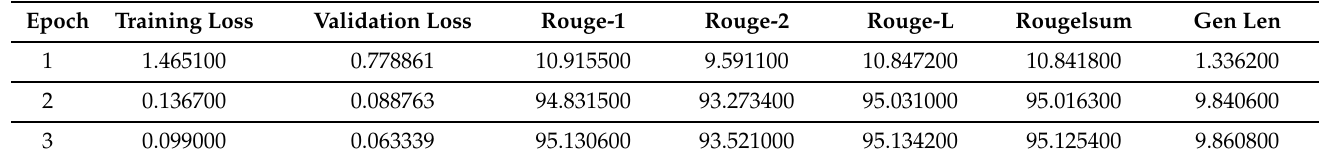
Table 6. Training process and results of Q2S before augmentation (on MEDIQA-2019).